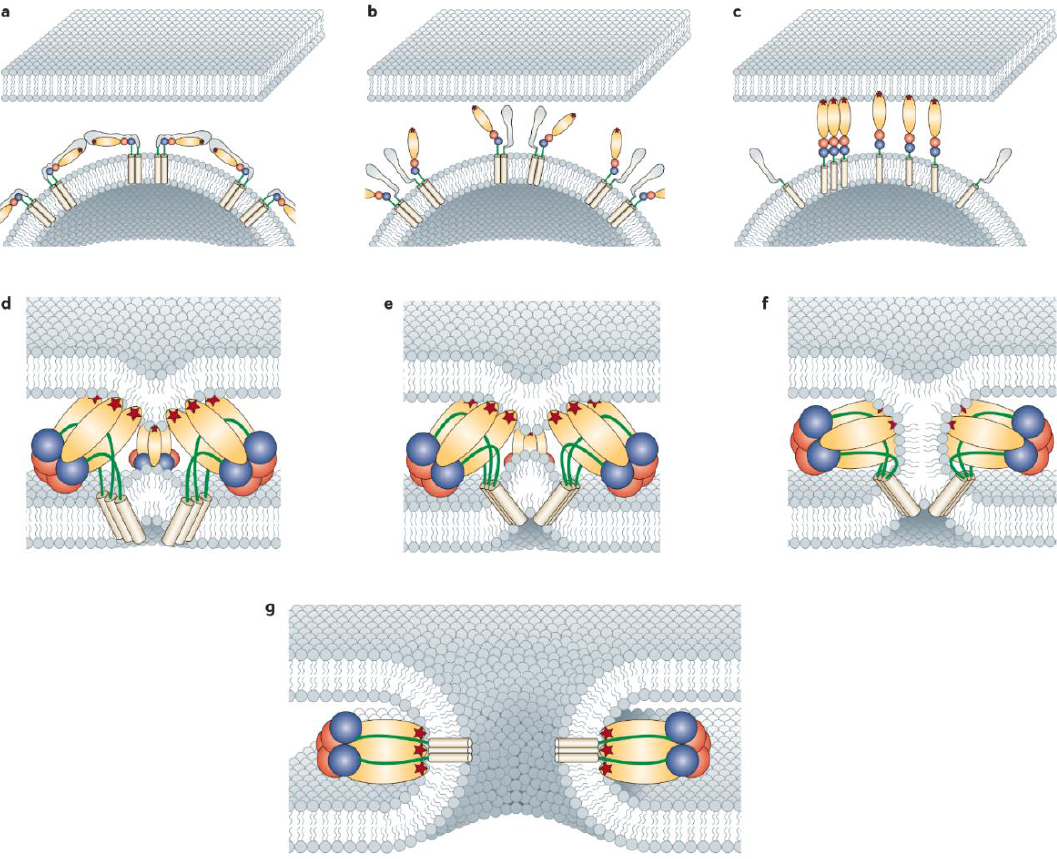
Figure 3. Model of alphavirus membrane fusion [145]. ( a ) On a mature virion, 240 copies of E1 and E2 are arranged as 80 trimeric spikes; a single spike consisting of three E2/E1 heterodimers. Domains of E1 are colored as in figure 1; E2 is shown in gray. The E1 hydrophobic fusion loop (indicated as a star) is buried in a groove between domain A and domain B of E2; ( b ) Destabilization of the E2/E1 heterodimer is triggered once the virus is exposed to the mildly acidic pH. Domain B of E2 moves away and the E1 fusion loop is exposed; ( c ) Insertion of the fusion loop into the target membrane and dissociation of the E2 protein. Formation of a E1 core trimer between DI and DII; ( d , e ) Re-folding of E1 DIII and stem region to form a hairpin-like homotrimer, forcing the two opposing membranes together; ( f ) Merging of the opposing membrane leaflets (hemifusion); ( g ) Formation of the final stable homotrimer and opening of the fusion pore. (Figure reprinted with permission from Nature Reviews Microbiology).